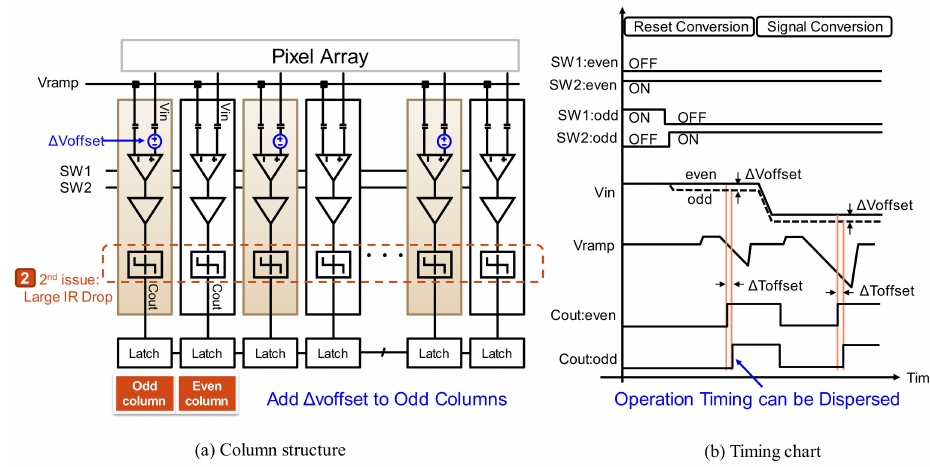
Figure 5. Concept of timing shift ADC.